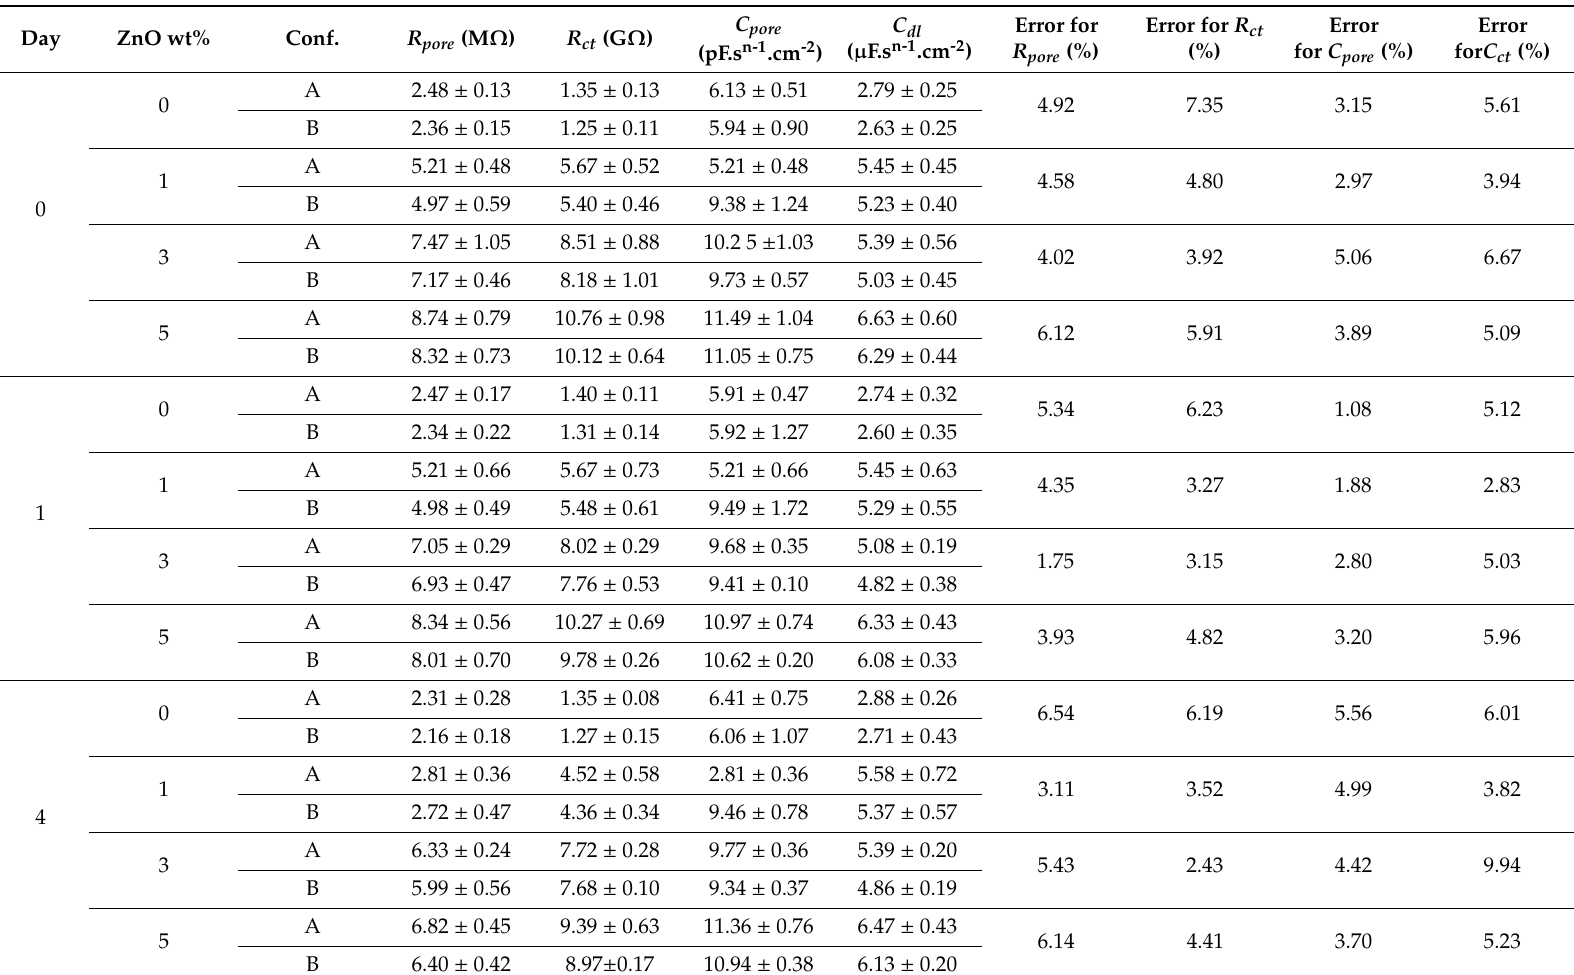
Table 4. Electrochemical equivalent circuit (EEC) parameters at di ff erent time and